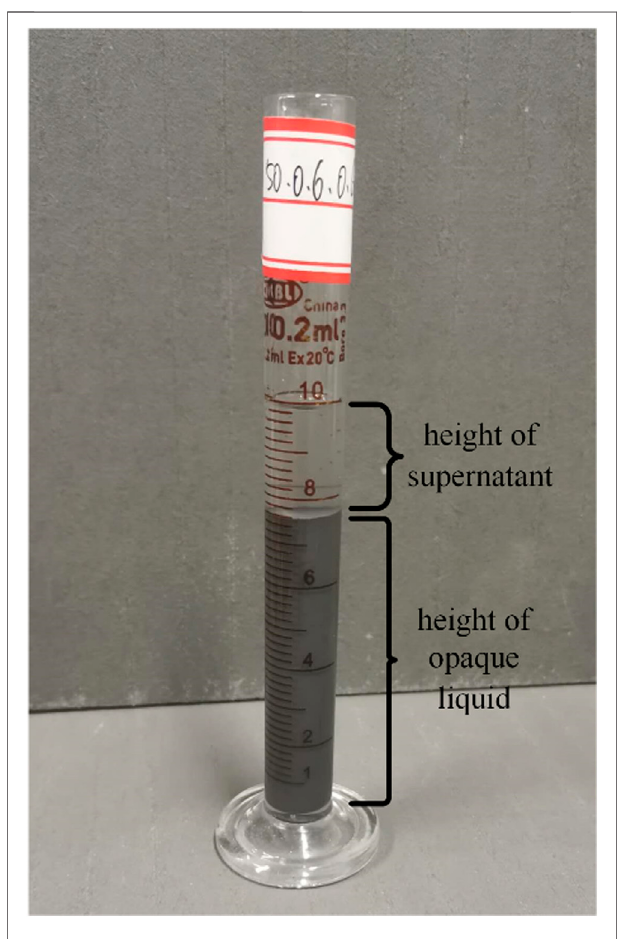
FIGURE 6 | Measuring